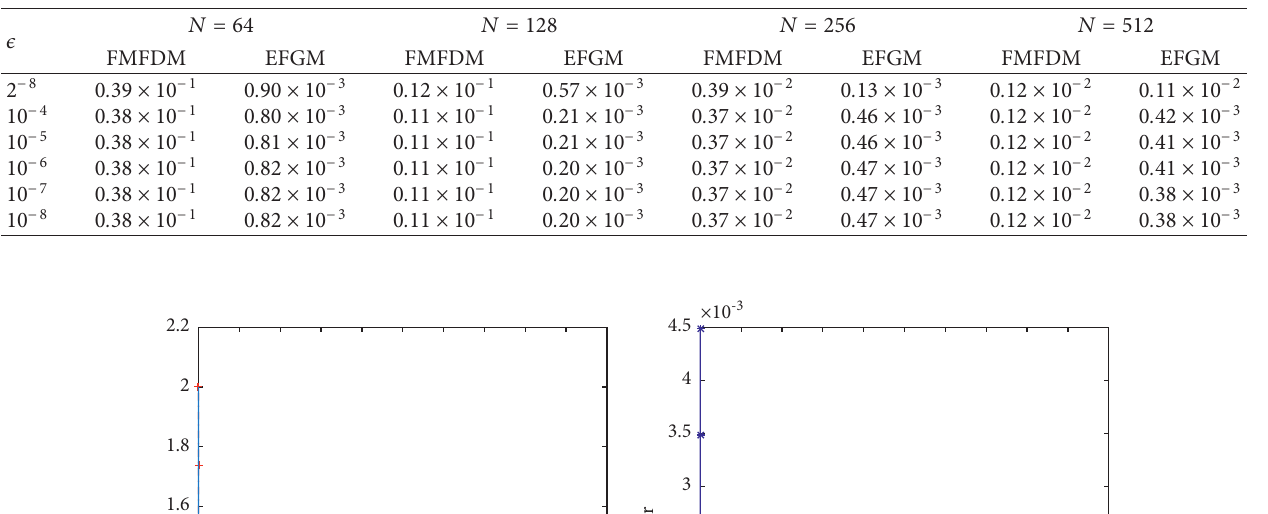
Table 8: Comparison of L errors for the FMFDM [39] and EFG method for Example 2. ∞